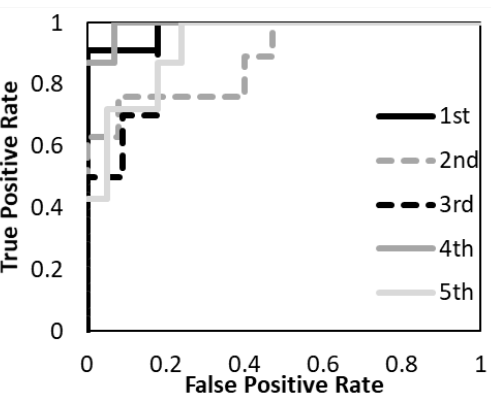
Figure 7. The performance of the predictive model with T1- and T2- weighted MR images was eval- uated according to the ROC metrics. Table 5. Assessment of the predictive performance of the predictive model for training and testing data with T1-weighted MR image (T1), T2-weighted MR image (T2), and the combination of T1- and T2-weighted MR images (T1&T2).